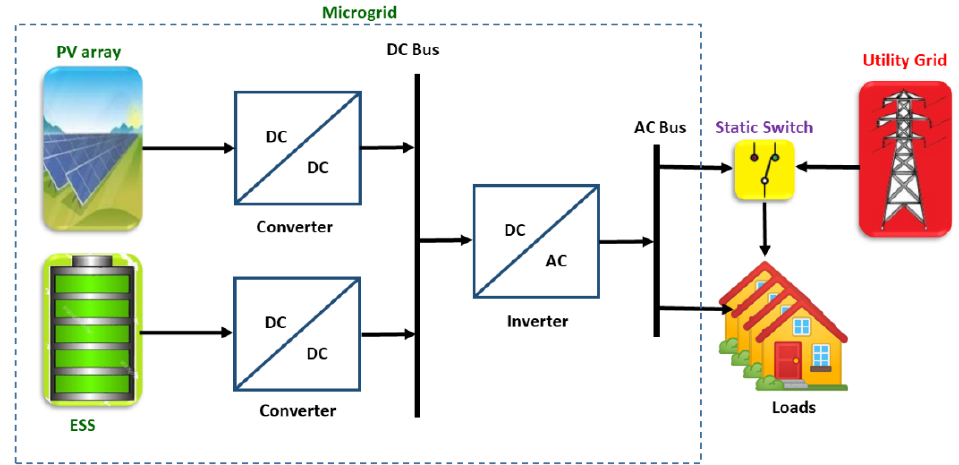
Figure 4. Microgrid Architecture.